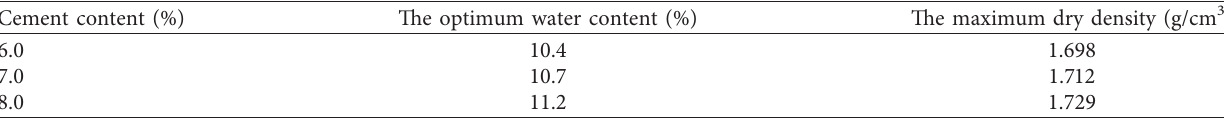
Table 5: The optimum water content and the maximum dry density.